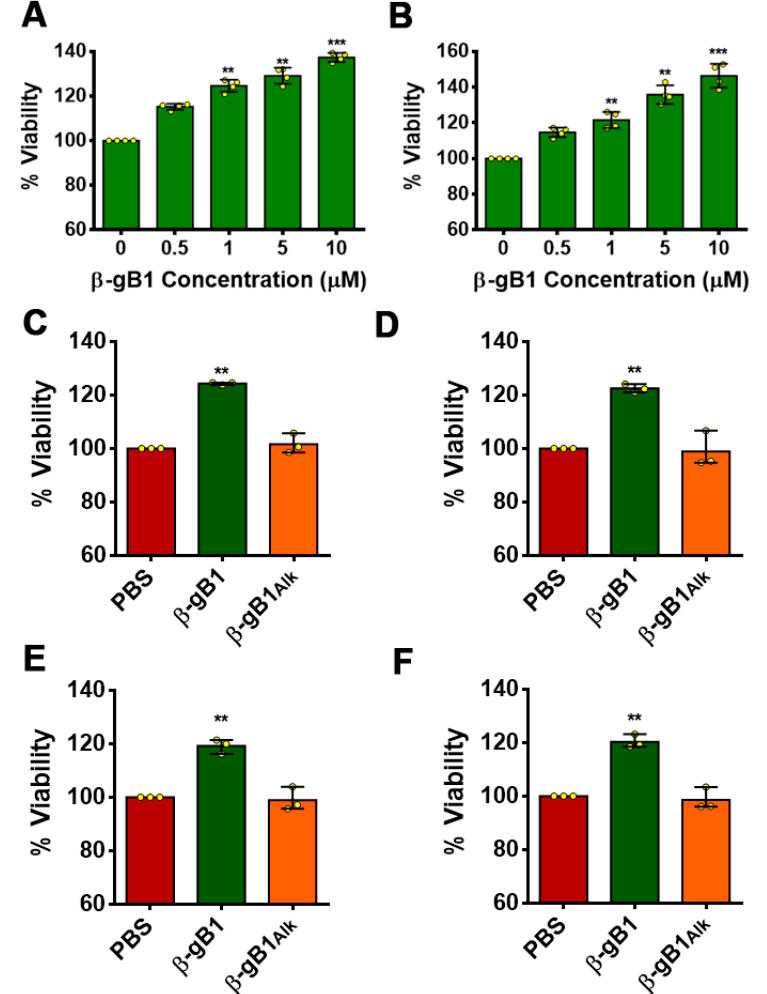
Figure 3. E ff ect of β -ginkgotide against hypoxia and hypoxia-reoxygenation-induced cell death. Cells were cultured with β -gB1 / S -alkylated β -gB1 ( β -gB1 Alk , see Scheme 1 legend) under hypoxia / hypoxia-reoxygenation condition for 48h, and viability was measured by an MTT assay. PBS was used as a vehicle control. Dose-response of β -gB1 upon cell survivability of H9c2 ( A ) and SH-SY5Y ( B ) cells under a hypoxic environment. Relative survival of H9c2 ( C ) and SH-SY5Y ( D ) cells upon 1 µ M β -gB1 treatment during 48h hypoxia. Relative survivals of H9c2 ( E ) and SH-SY5Y ( F ) cells upon 1 µ M β -gB1 treatment during hypoxia-reoxygenation stress. Viabilities are expressed as mean values, and statistical significance was calculated from three independent experimental replicates. ** p < 0.005 and *** p <